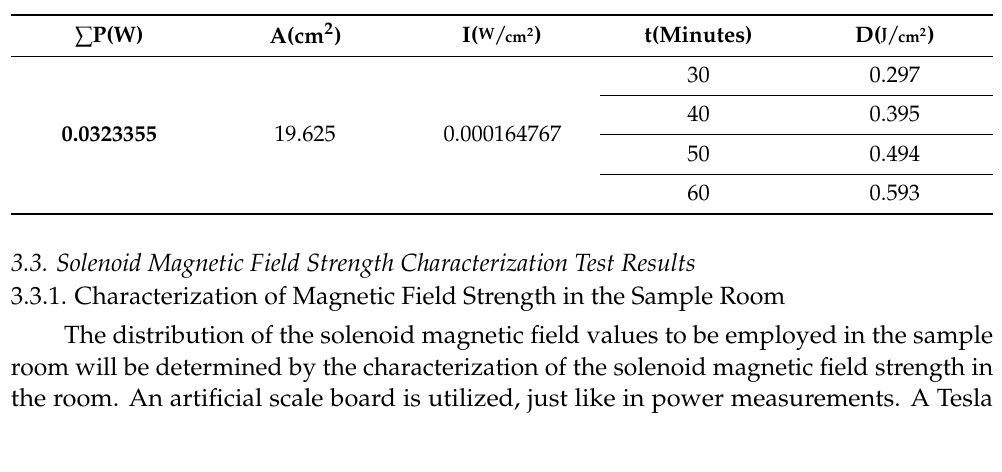
Table 2. Intensity and Energy Dose Values of Infrared